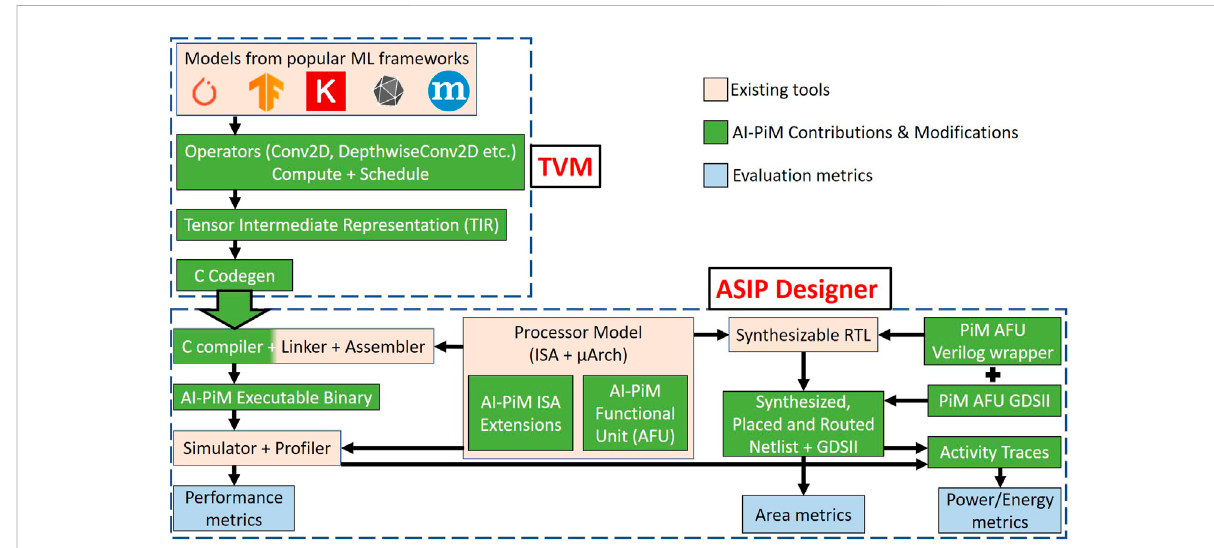
FIGURE 6 AI-PiM hardware, ISA and software co-design methodology consisting of TVM deep learning compiler (Chen et al. (2018)) as the frontend compiler to map models from popular machine learning frameworks to C and Synopsys ASIP Designer (Synopsys (2022)) as the backend processor designtooltogeneratecompleteSDKandsynthesizableRTL.AI-PiMcontributionsandmodi fi cationstoexistingtoolstosupportPiMfunctionalunits across the hardware and software stacks have been highlighted in green.